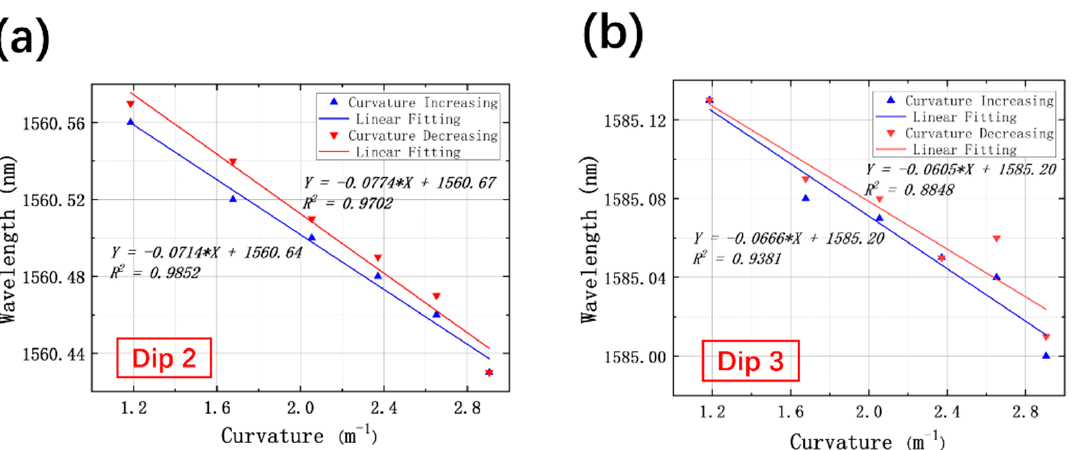
Figure 6. Relationship between the wavelength of resonant dips and curvature with curvature increasing and decreasing for ( a ) Dip 2 and ( b ) Dip 3.